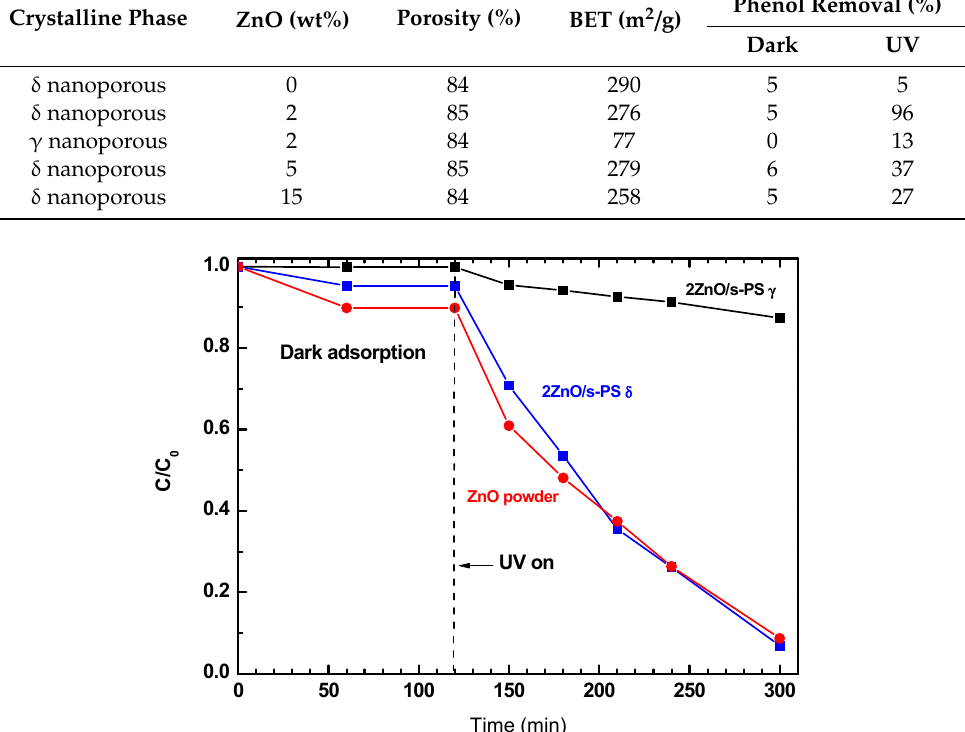
Table 1. ZnO dosage, aerogel apparent porosity, BET surface area of ZnO/s-PS aerogels with different polymer crystalline phases. Phenol removal in dark (after 120 min) and UV irradiation (after 300 min), obtained by using ZnO/s-PS aerogels in aqueous solutions containing 50 mg/L of phenol at PH = 6.7.